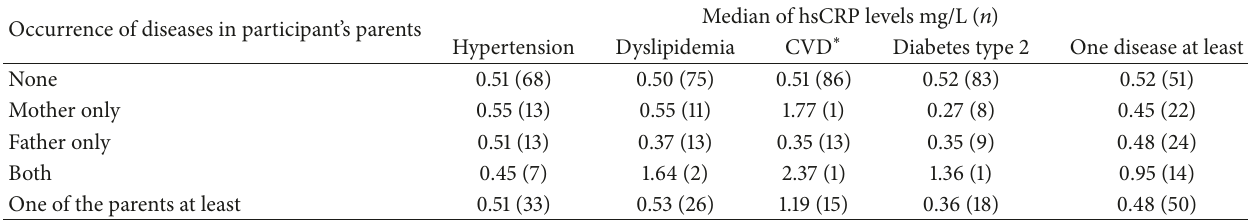
Table 5: Participants grouped by the occurrence of diseases in their parents. Median of hsCRP levels (mg/L) and participants numbers (𝑛) of each group were shown (𝑛 = 101 ). Damascus, Syria, April